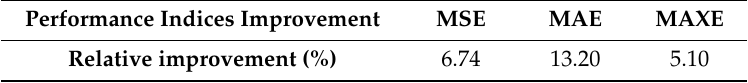
Table 4. Relative performance improvement of the SMO-based estimator over the phasor diagram based estimator during dynamic disturbances of reactive power for generator operating point P = 0.89, Q = 0.